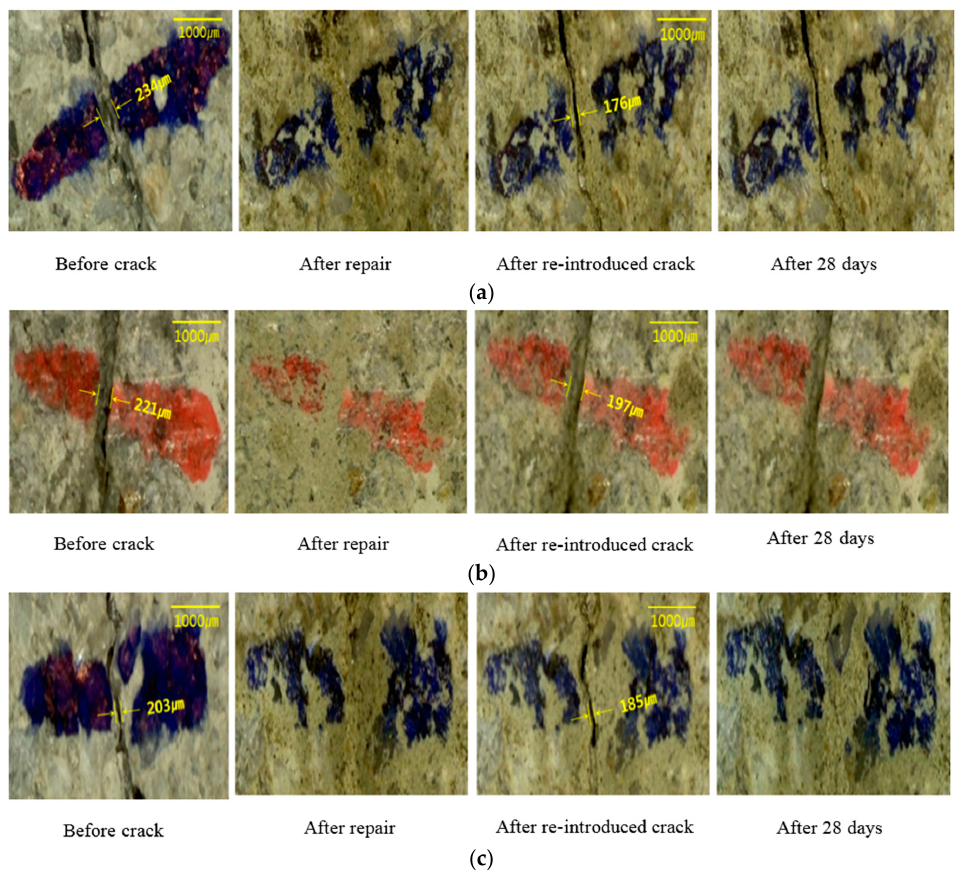
Figure 11. Observation of crack closure due to healing performance using microscope: ( a ) specimen by repairing C.R.S 1 and ( b ) specimen by repairing C.R.S 2 and ( c ) specimen by repairing C.R.S